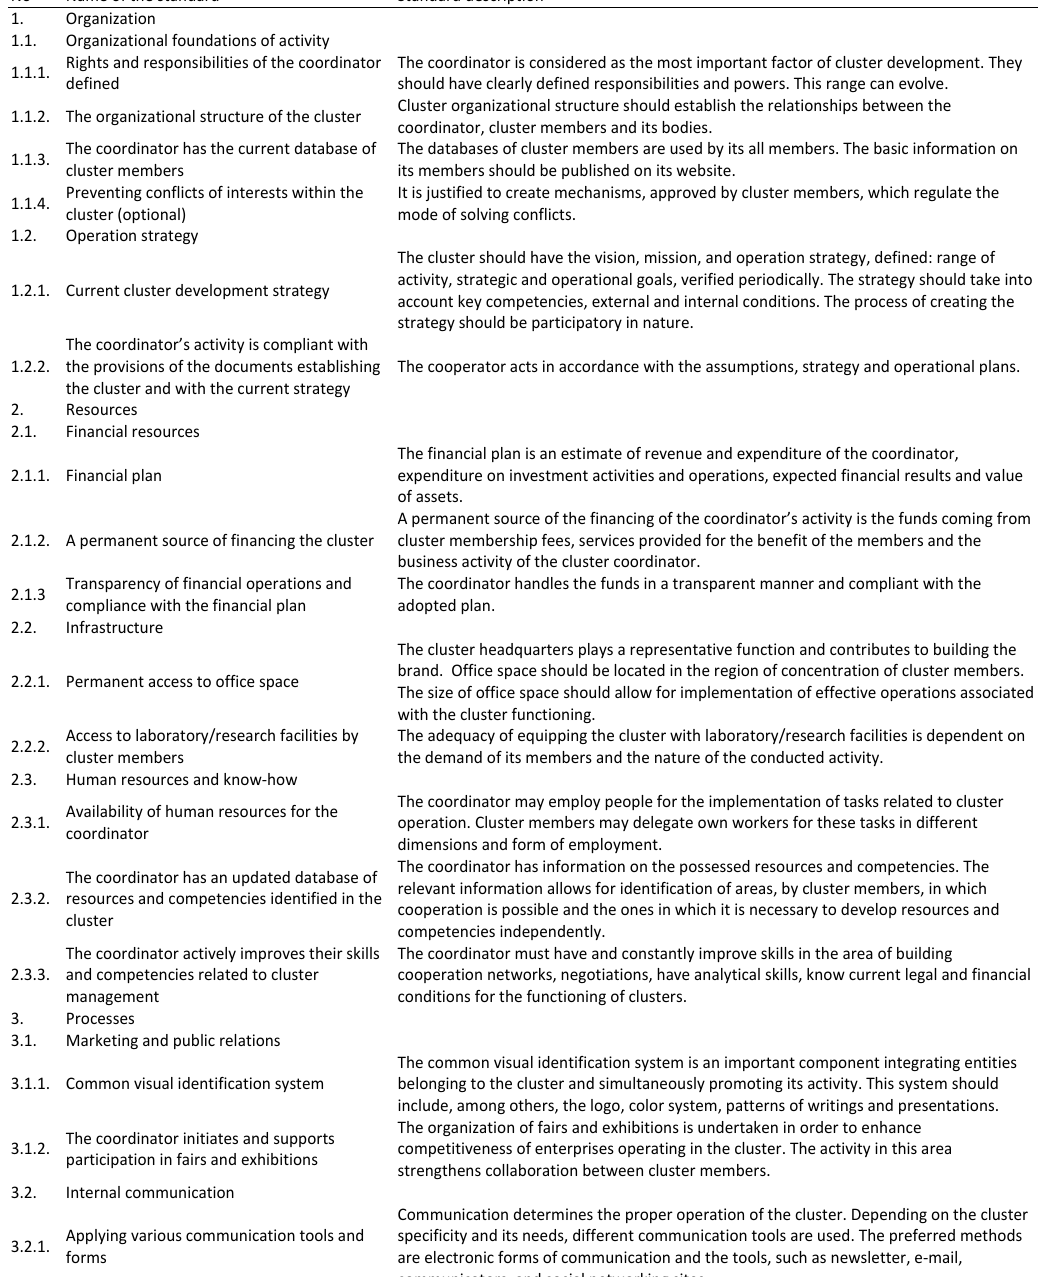
Table 2: Cluster management standards in Poland (SZK, 2015 and 2015)